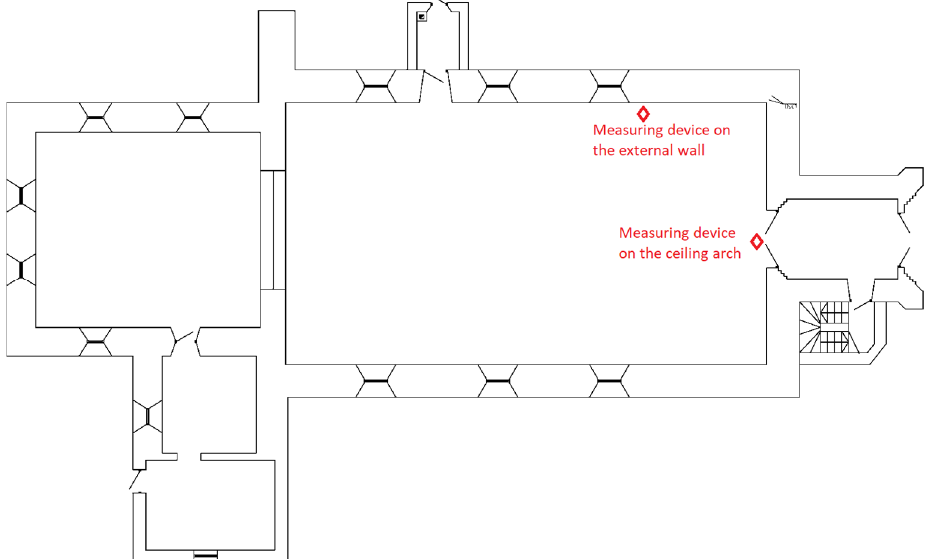
Figure 4. Krimulda church plan with locations of the measuring devices.